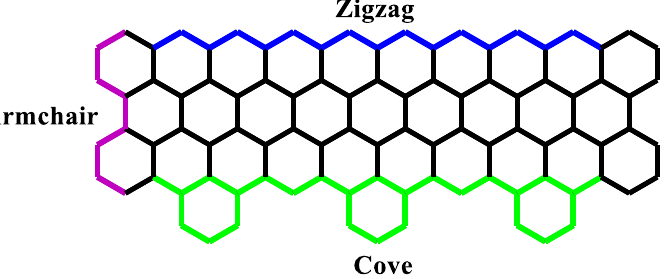
Figure 1. Types of edges in graphene nanoribbon.